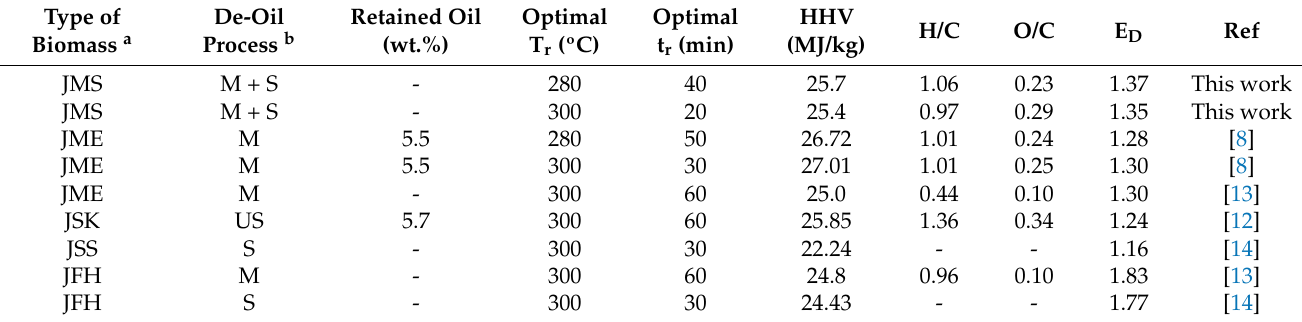
Table 2. Comparison of main properties of torrefied Jatropha biomass by various oil extraction processes. Type of